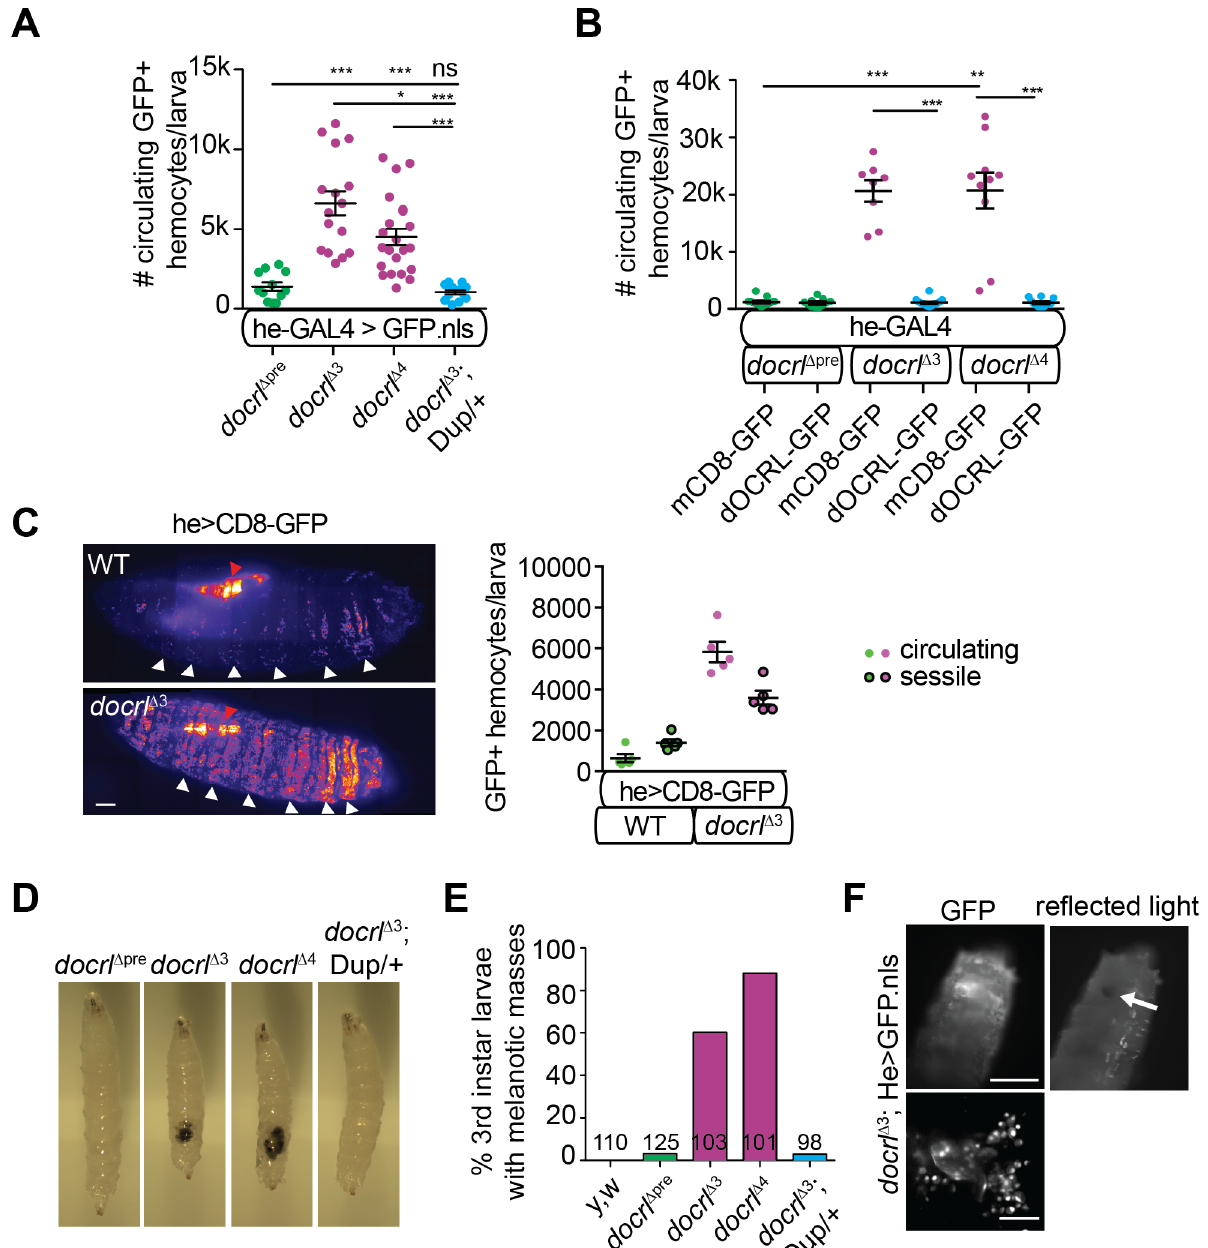
Fig 1. dOCRL is required in hemocytes to restrict hemocyte abundance. (A-B) Absolutequantification of hemocytesin hemolymph extracted from wanderingthird instar larvae. (A) docrl mutants exhibit increasedcirculating hemocytes. (B) Re-expression of dOCRL in hemocytes is sufficient to suppresshemocyte number. (C) 2D projectionof confocalimages showinghemocyte distributionin larvae (left). Red arrows indicate salivary glands (a common site of expressionfor GAL4 drivers); white arrows indicate hematopoietic pockets. Scale bar is 200 μ m. Quantification of circulating (releasedupon openingof the larvalcuticle) and sessile (retainedin the larval carcass) hemocytes in control and docrl Δ 3 larvae(right). Controlgenotypeis w; CD8-GFP/+; he-GAL4/+. (D) docrl mutant larvaeexhibit melanotic masses, which are rescuedby docrl gene duplication Dup(1;3)DC402. (E) Frequency of visible melanoticmasses. (F) Epifluorescence and reflected light images of a docrl Δ 3 larva showingGFP-labeled hemocytesclustered arounda melanoticmass (arrow). Scale bar is 500 μ m. (right) 2D projectionof confocalimage of hemocytessurroundinga melanoticmass. Scale bar is 50 μ m. Associated with S1 and S2 Figs.